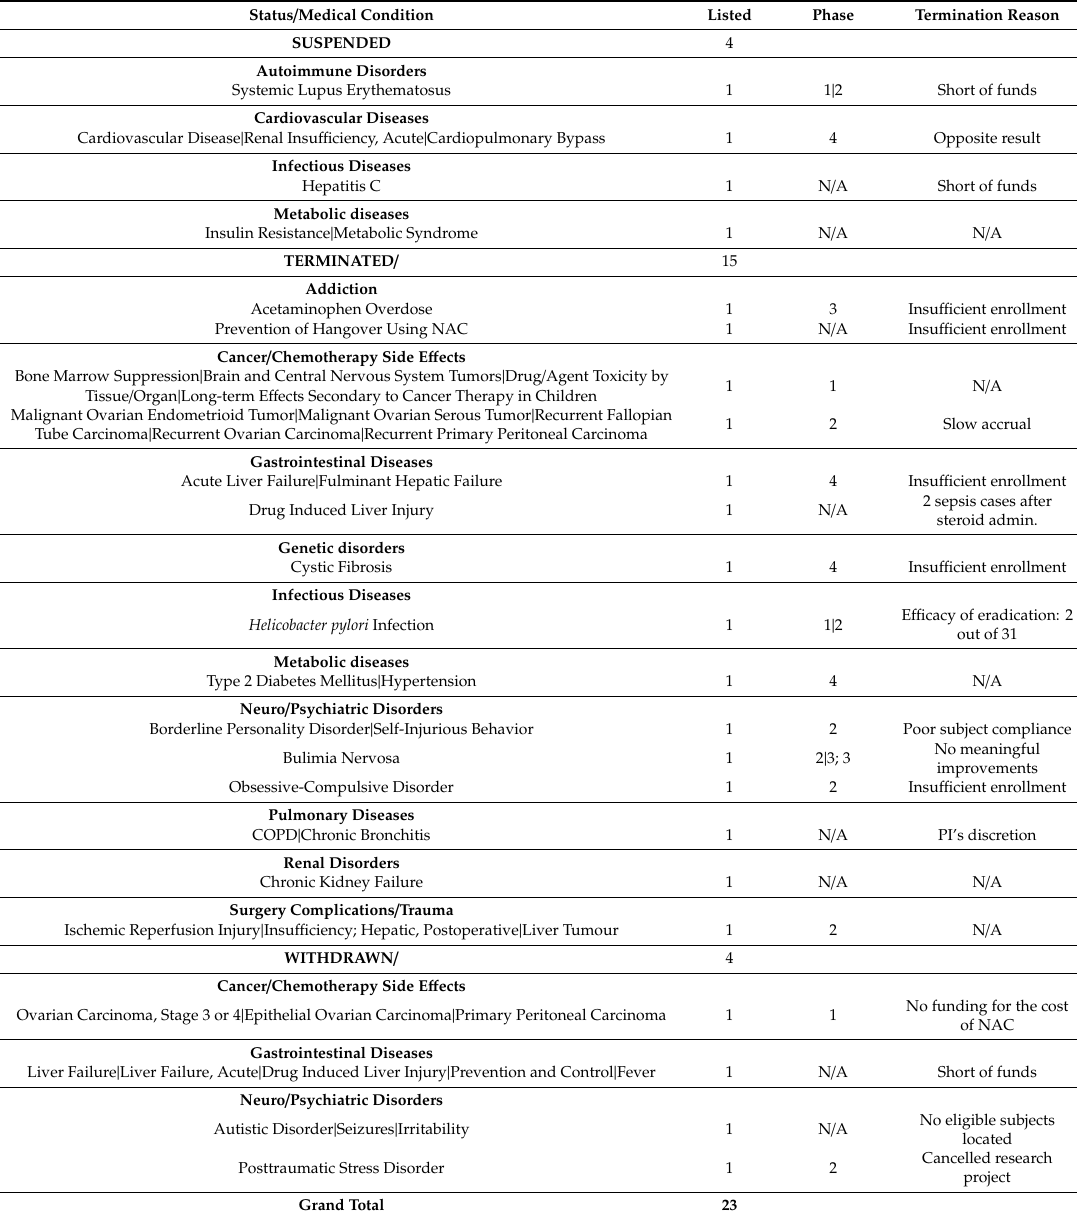
Table 3. Medical conditions investigated by withdrawn, terminated, and suspended studies listed by ClinicalTrials.gov [48]. Listed: number of trials listed at ClinicalTrials.gov [48]; Phase: study phase; N / A: not